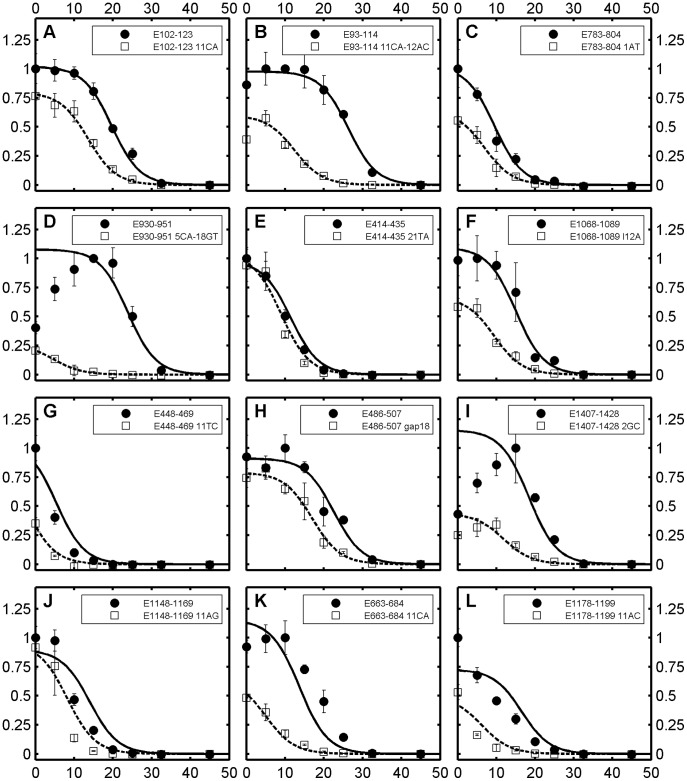
Formamide melting profiles of 12 arbitrarily selected perfect match probes and their mismatched versions.All perfect matches are from the TileE set, since only this set has mismatched versions (for examples from the Length set, see Figure S1A). Solid and dashed curves indicate theoretical profiles for perfect matches and mismatches, respectively. x-axis, formamide concentration; y-axis, normalized signal intensity; error bars, standard deviations.